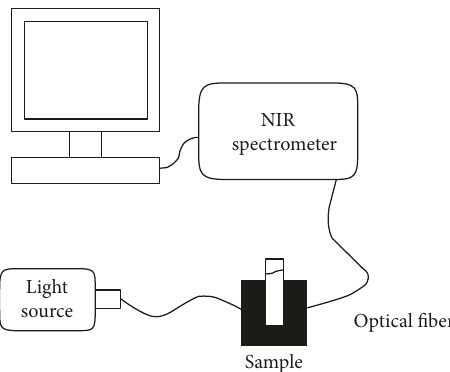
Figure 1: Schematic representation of the NIR spectra measuring